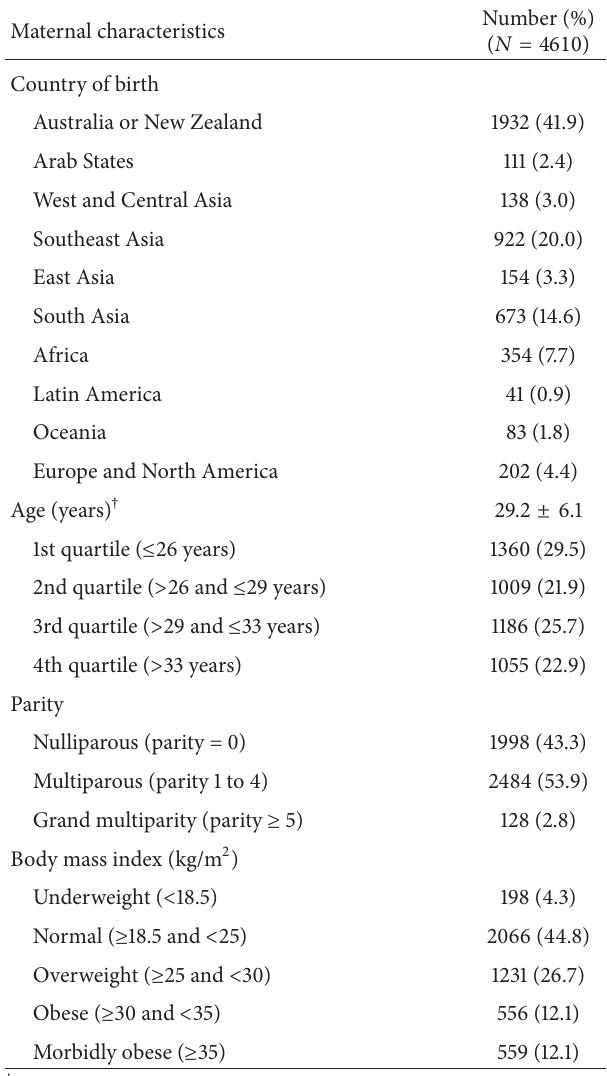
Table 2: Demographic characteristics of women included in the study